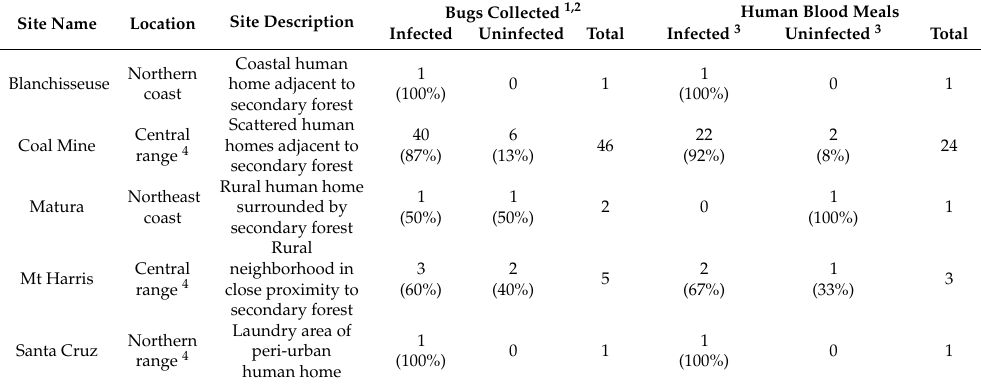
Table 1. Triatomine Bug Collection Site Descriptions with T. cruzi Infection Status of Bugs Collected from Each Site, and Human Blood Meals Taken by the Bugs. Only Successful Collection Site Details Are Listed. Details for Every Sample Site Are in Table